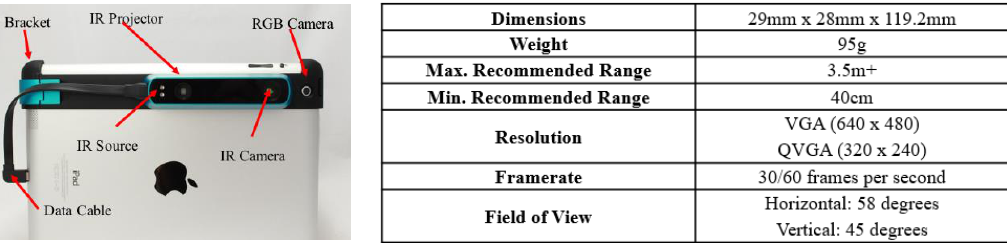
Figure 3. The comparison between the raw depth and calibrated depth.